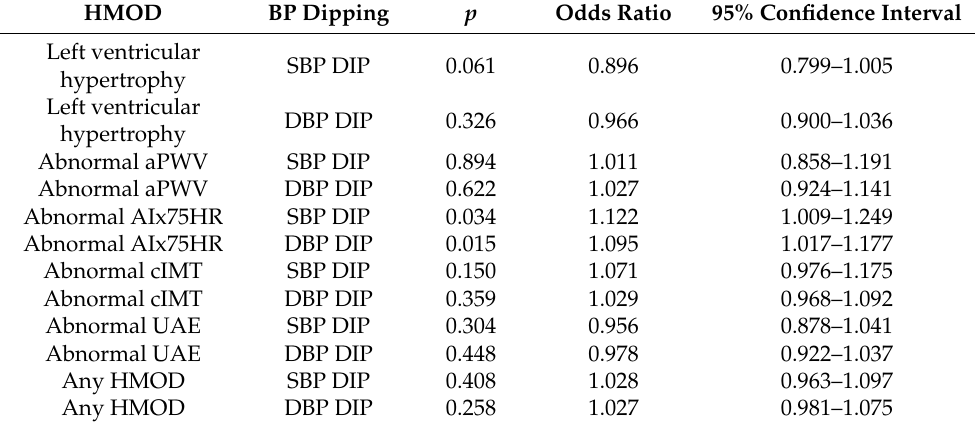
Table 8. Systolic and diastolic blood pressure dipping (continuous variable) and risk for hypertension- mediated organ damage—analysis by logistic regression (unadjusted odd